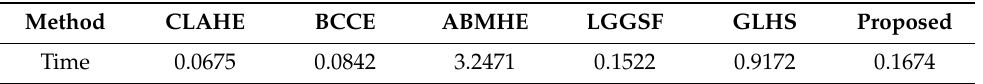
Table 2. The average time consumption of the six methods on the six captured test images (Unit: